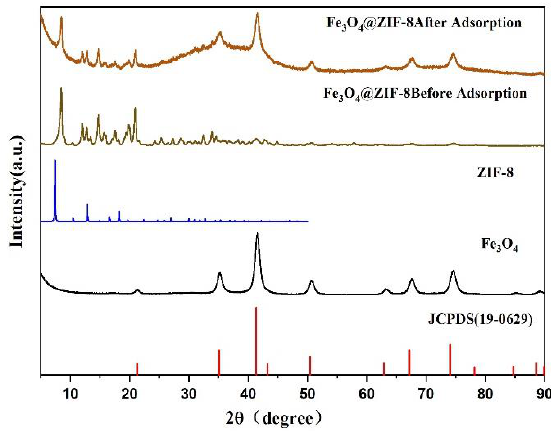
Figure 8. XRD pattern of synthesized Fe 3 O 4 @ZIF-8, Fe 3 O 4.